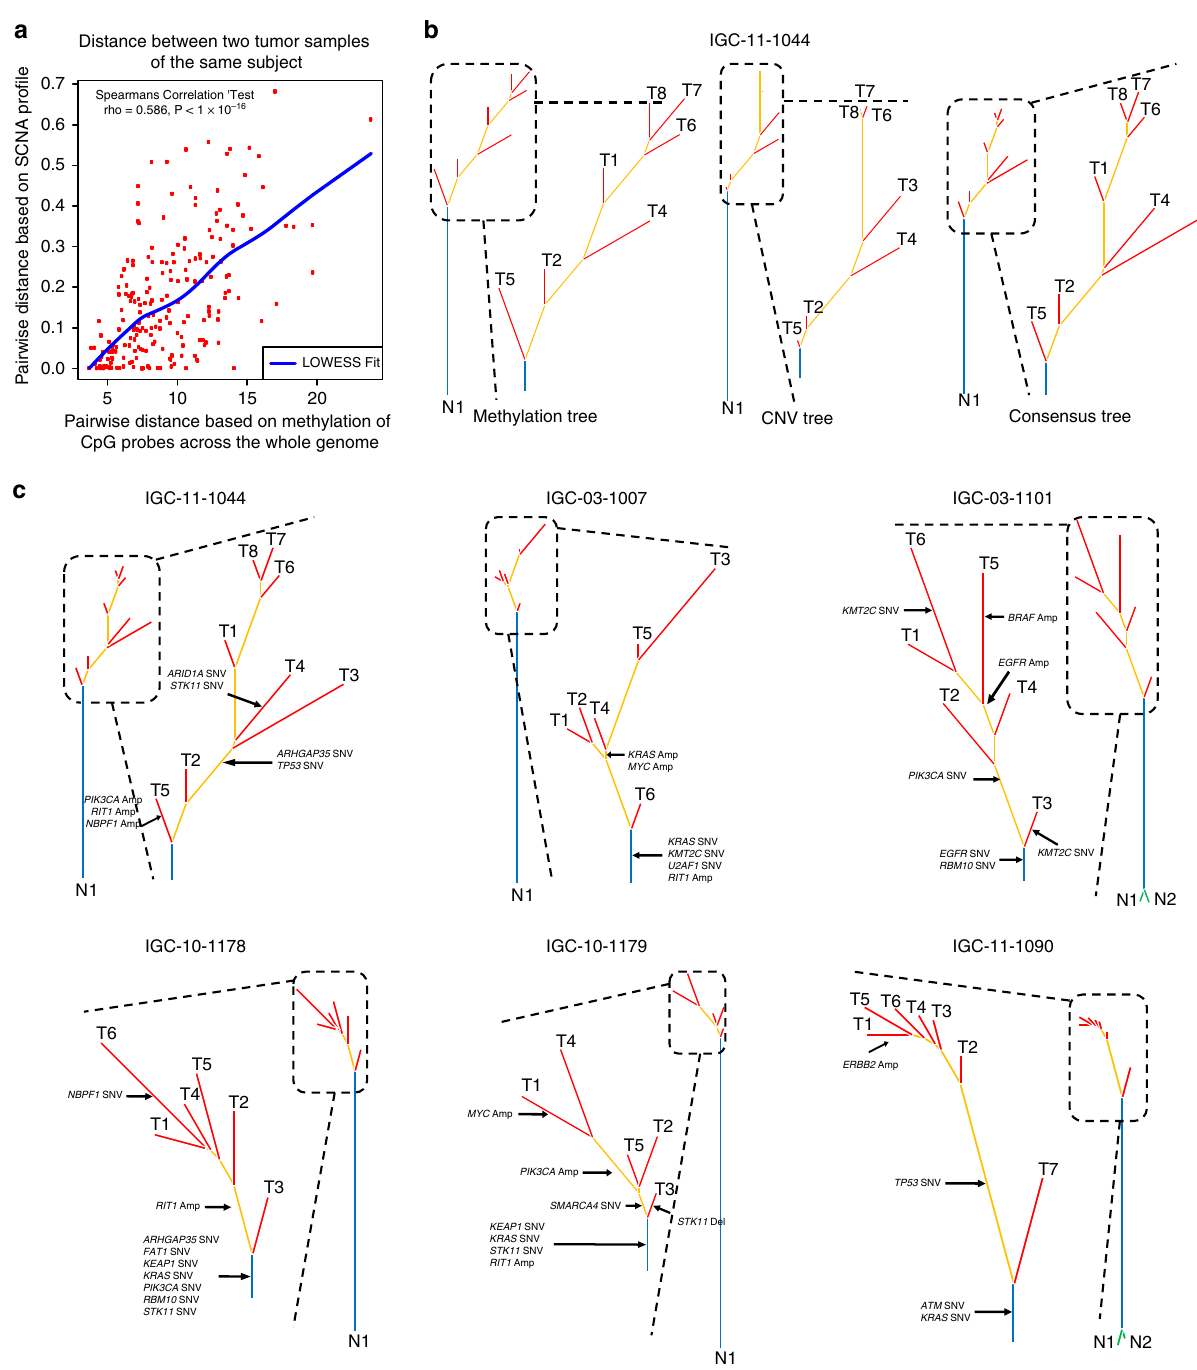
Fig. 6 Reconstruction of evolutionary trajectories from SCNA and DNA methylation pro fi les. a Pairwise distance of tumor samples from the same tumor based on DNA methylation and SCNA pro fi les. Each dot represents a pair of tumor samples from the same subject. Signi fi cant Spearman ’ s correlation coef fi cient is shown ( n = 212 tumor sample pairs). b Phylogenetic analysis of subject IGC-11-1044 based on DNA methylation and SCNA pro fi les, and the consensus phylogenetic tree built based on the distance incorporating both SCNA and DNA methylation pro fi les. Blue lines represent alterations shared by all tumor samples from the same subject. Yellow lines represent alterations shared by two or more tumor samples. Red lines represent alterations speci fi c to one tumor sample. Green lines represent alterations speci fi c to one normal sample. c Consensus phylogenetic trees for six tumors with at least fi ve samples assayed for both SCNAs and DNA methylation. SNVs, deletions of tumor suppressor genes and ampli fi cations of oncogenes are marked on the inferred phylogenetic Statistical analyses . Regional genetic and epigenetic evolutionary trees for each signi fi cantly higher or lower at signi fi cance level of 0.05 after adjusting for multiple patient were built using fastme.bal in an R package ape that uses the minimum comparisons, the segments were identi fi ed as ampli fi ed or deleted, respectively. evolution algorithm based on a distance matrix of SCNA or methylation pro fi les 25 . Otherwise they were identi fi ed as LOH. In addition, ampli fi cations with at least four copy numbers in oncogenes and deletions with zero copy number in tumor The consensus tree was built using a revised distance matrix combining both suppressor genes were identi fi ed as potential driver events. SCNA and DNA methylation pro fi les with methods described brie fl y below. Let d 1 ij